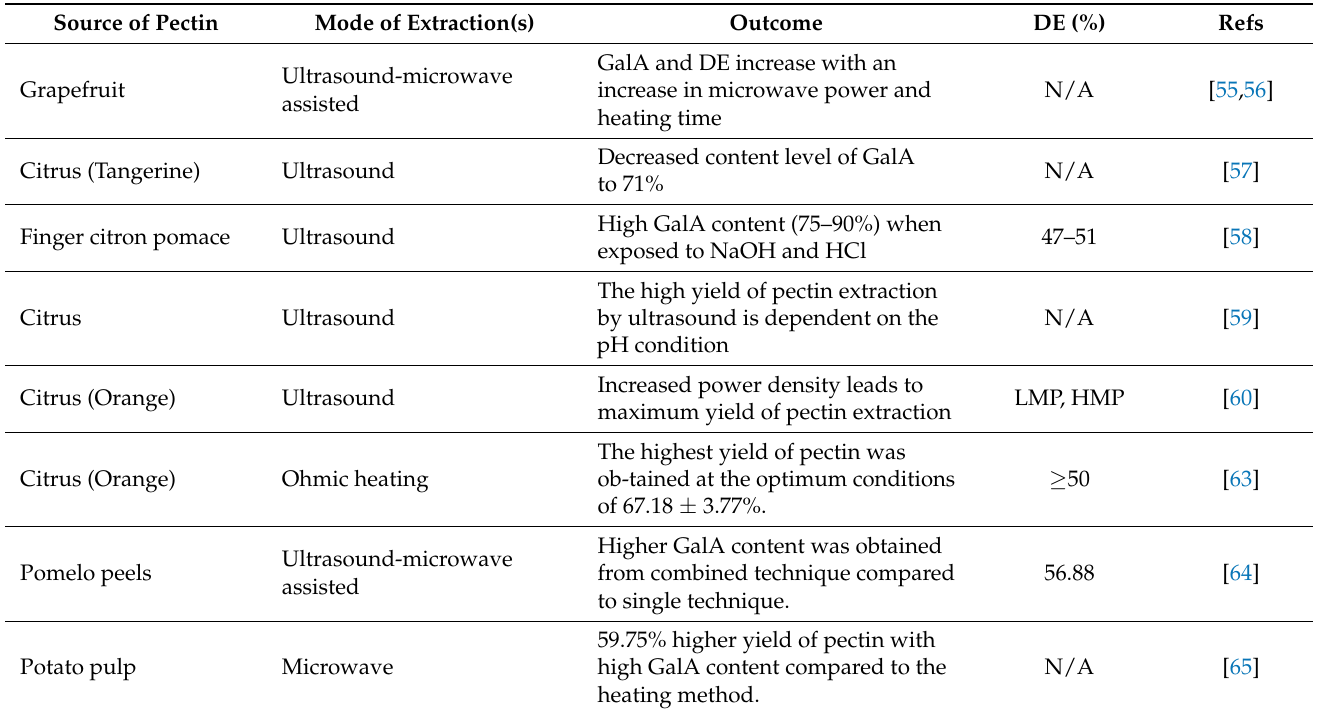
Table 1. Emerging extraction technologies of modified